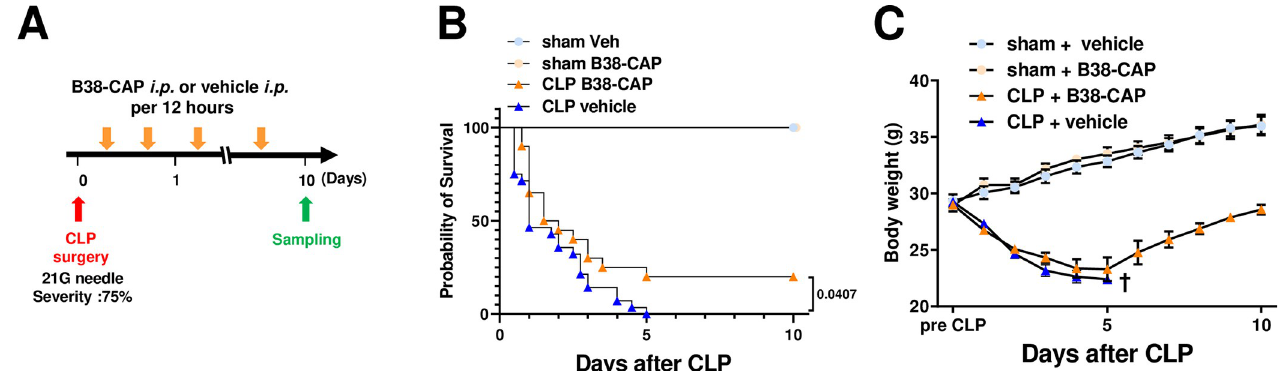
Fig 2. B38-CAP improves mortality of mice with CLP-induced abdominal sepsis. A , Experimental protocol of B38-CAP treatment for mice with CLP- induced sepsis. Intraperitoneal injection of B38-CAP (2 mg kg -1 pre i . p .) or vehicle were initiated at 6 hours after CLP surgery and repeated every 12 hours for 10 days. sham + vehicle (n = 6), sham + B38-CAP (n = 6), CLP + vehicle (n = 20) and CLP + B38-CAP (n = 28). B , Kaplan-Meier survival curves. P < 0.05 (log- rank test) when comparing the CLP + B38-CAP group with the CLP + vehicle group. C , Body weight change after CLP induction. All values are means ±